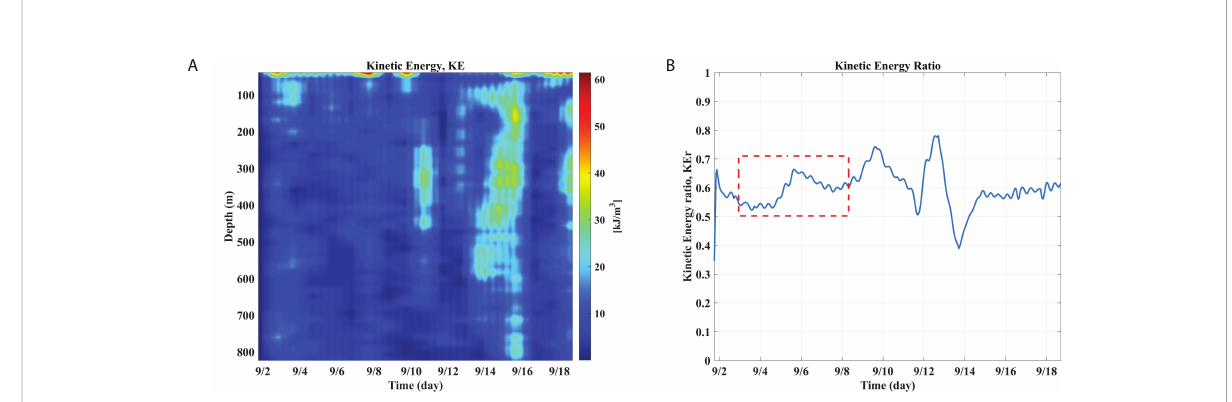
FIGURE 7 The horizontal kinetic energy (HKE), computed from the mode-1 fi tted current estimates, is presented in (A) , and the ratio of HKE of the upper 400 m with respect to the whole column down to 800 m is plotted in (B) . The red broken-line box in (B) indicates the time span during which the ISABU traveled across the target eddy ’ s center. Also, compared to the ratio of APE within the eddy, the behavior of HKEr is clearly distinguished. Note that HKE and APE are linearly dependent via a linear internal wave